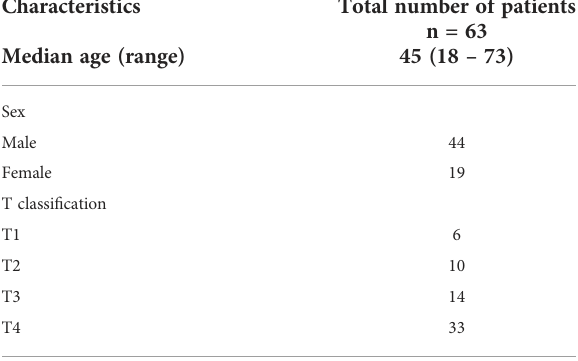
TABLE 1 Demographic characteristics of the NPC patients included in the